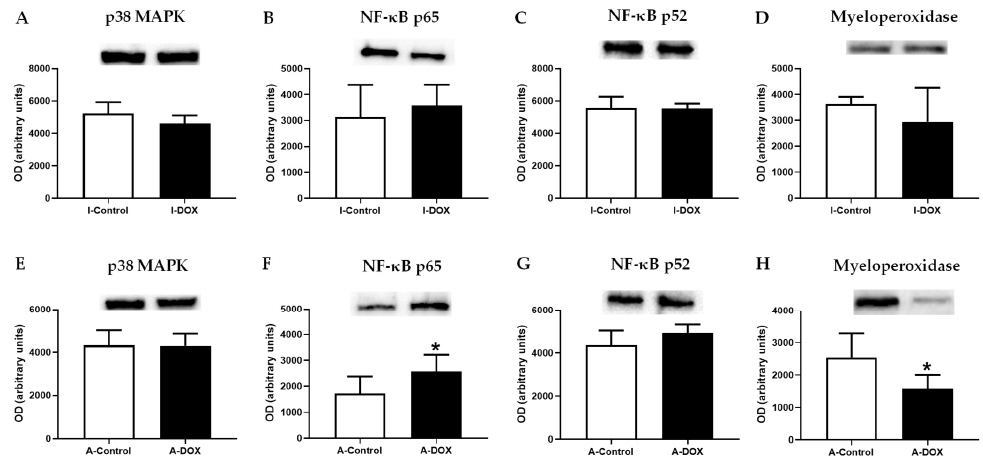
Figure 9. ( A , E ) p38 MAP Kinase (p38 MAPK) (40 kDa), ( B , F ) NF- κ B p65 (60 kDa), ( C , G ) NF- κ B p52 (50 kDa), ( D , H )